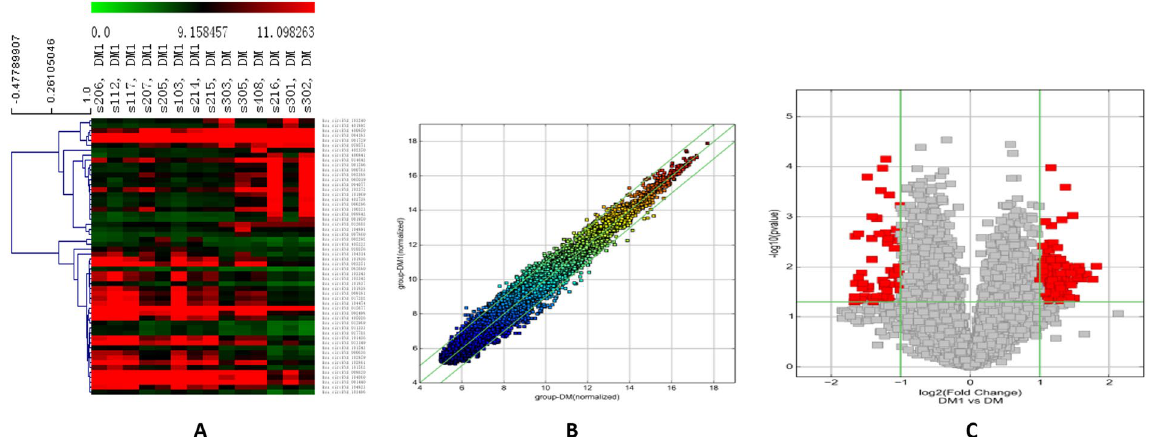
Figure 1. Differential expression of circRNAs in T2DM patients with depression. ( A ) Hierarchical clustering of circRNAs. Hierarchical clustering analysis of circRNAs that were differentially expressed between T2DM (DM) and T2DM with depression (DM1) groups; each group included seven individuals (fold change > 2; P < 0.05). ( B ) Scatter plot of circRNAs. Scatter plots were created to assess variations in circRNA expression between DM and DM1 samples. The values corresponding to the X- and Y-axes are the normalised signal values. ( C ) Volcano plots of circRNAs. Volcano plots were constructed by fold-change and p values. The vertical lines correspond to P values, and the horizontal lines represent log2 (fold change) up- and downregulation between DM1 versus DM samples. The red points show the significantly differentially expressed circRNAs.